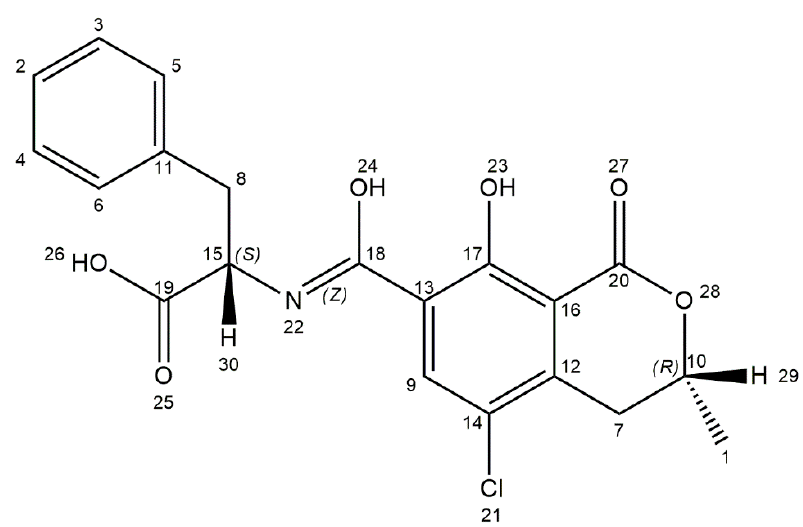
Figure 2. Chemical structure of ochratoxin A (structure generated from InChI code available on https://pubchem.ncbi.nlm.nih.gov/) (accessed on 16 August 2020).